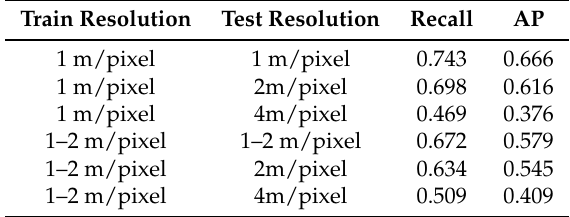
Table 13. Average results calculated from Section 4. Recall and AP are obtained from the average calculation of the experimental results of all models under the corresponding training and test